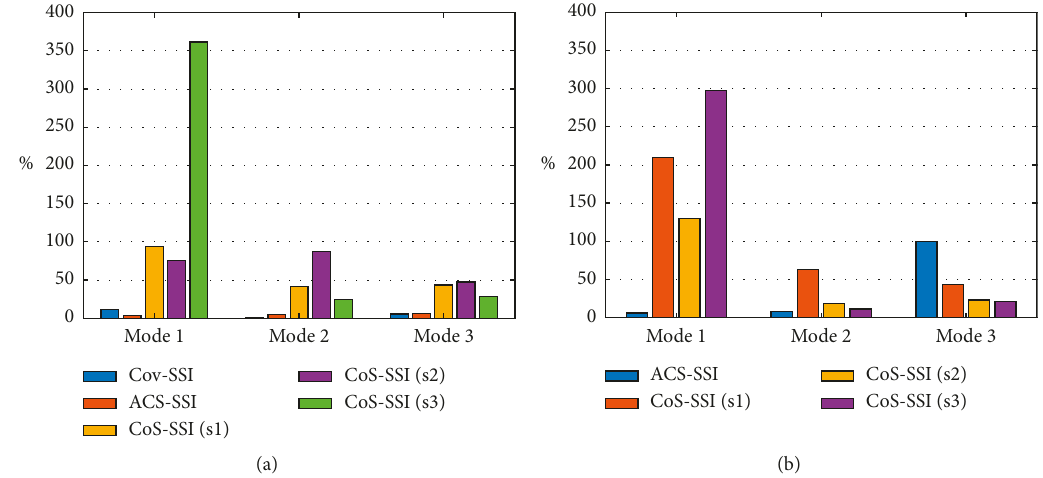
Figure 9: Identified damping errors. (a) Identified damping errors (SNR